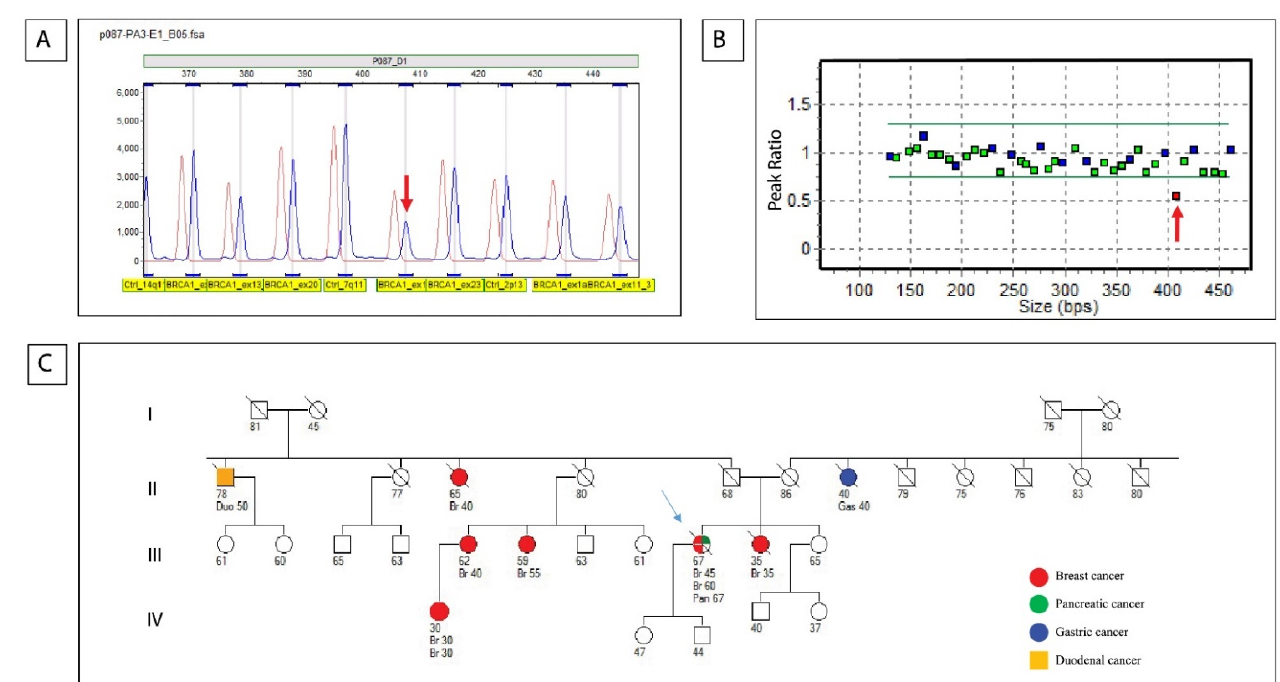
Figure 4. Confirmation of the presence of the germline deletion of exon 16 of BRCA1 in PA3 non- neoplastic tissue, using the SALSA ® MLPA ® P087-D1 probe mix. Raw data indicating a deletion of the BRCA1 probe sized 407 kb ( A , B ); two different graphical representation of the results using GeneMarker ® software from SoftGenetics v.3.0.1. The arrows indicate the deleted probes. The expected result for a heterozygous deletion is 0.40 < DQ < 0.65. ( C ) Family history of PDAC patient carrier of germline BRCA1 exon 16 deletion indicated by light blue arrow.